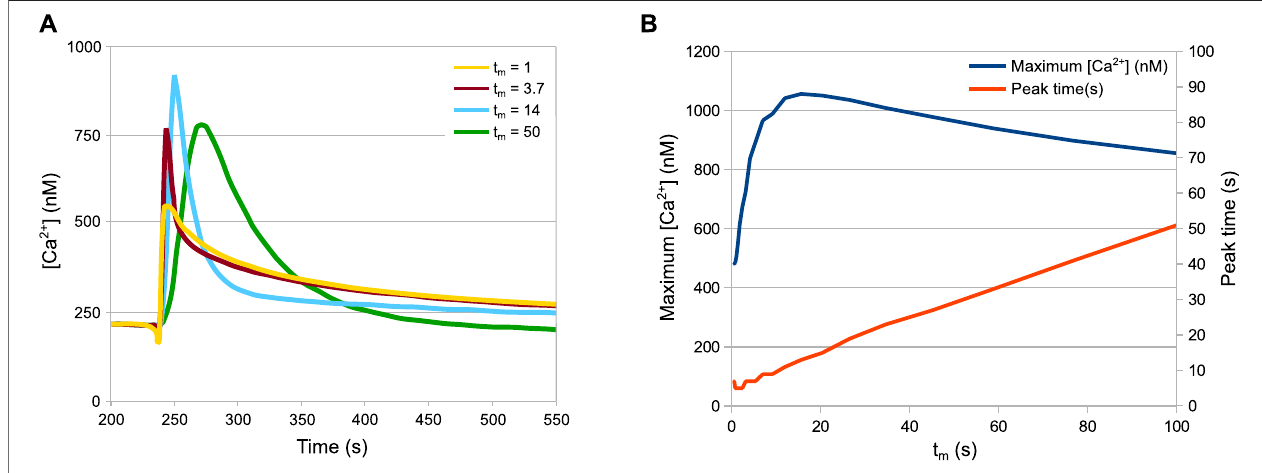
FIGURE 6 | Behaviour of the system depending on the speed of the HTS. (A) Ca 2+ peaks in response to different dilution speeds. (B) Maximum Ca 2+ values and time of maximum Ca 2+ values depending on the dilution speed. The t m parameter is inversely proportional to the speed of dilution. Increasing the speed of dilution increases the speed of response but not necessarily the peak